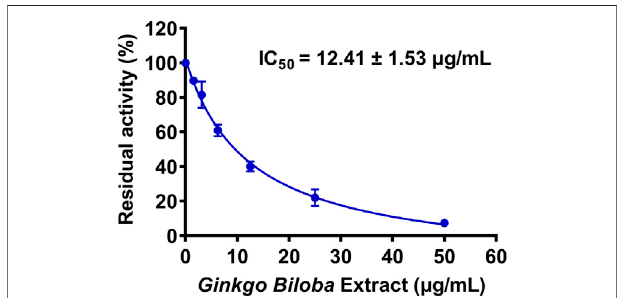
FIGURE 1 | Dose-inhibition curve of Ginkgo biloba leaf extract on UGT1A1-catalyzed NHPN- O -glucuronidation in HeLa-UGT1A1 cells. The data were expressed as the means of triplicate